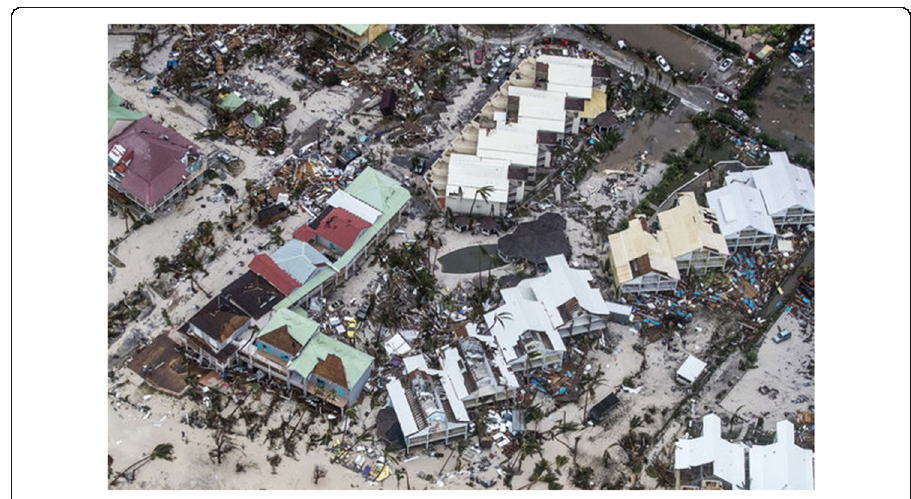
Fig. 1 Wind-induced damage from Hurricane Irma